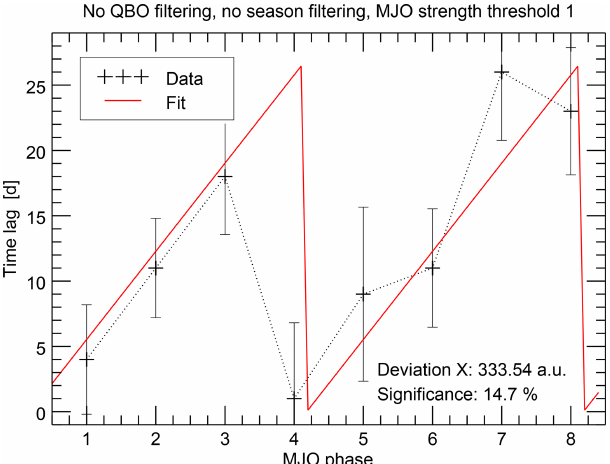
Figure 8. As in Fig. 5, but also showing the analysis results for the epochs being started with solar maximum. The green line corre- sponds directly to the green line in Fig. 5.